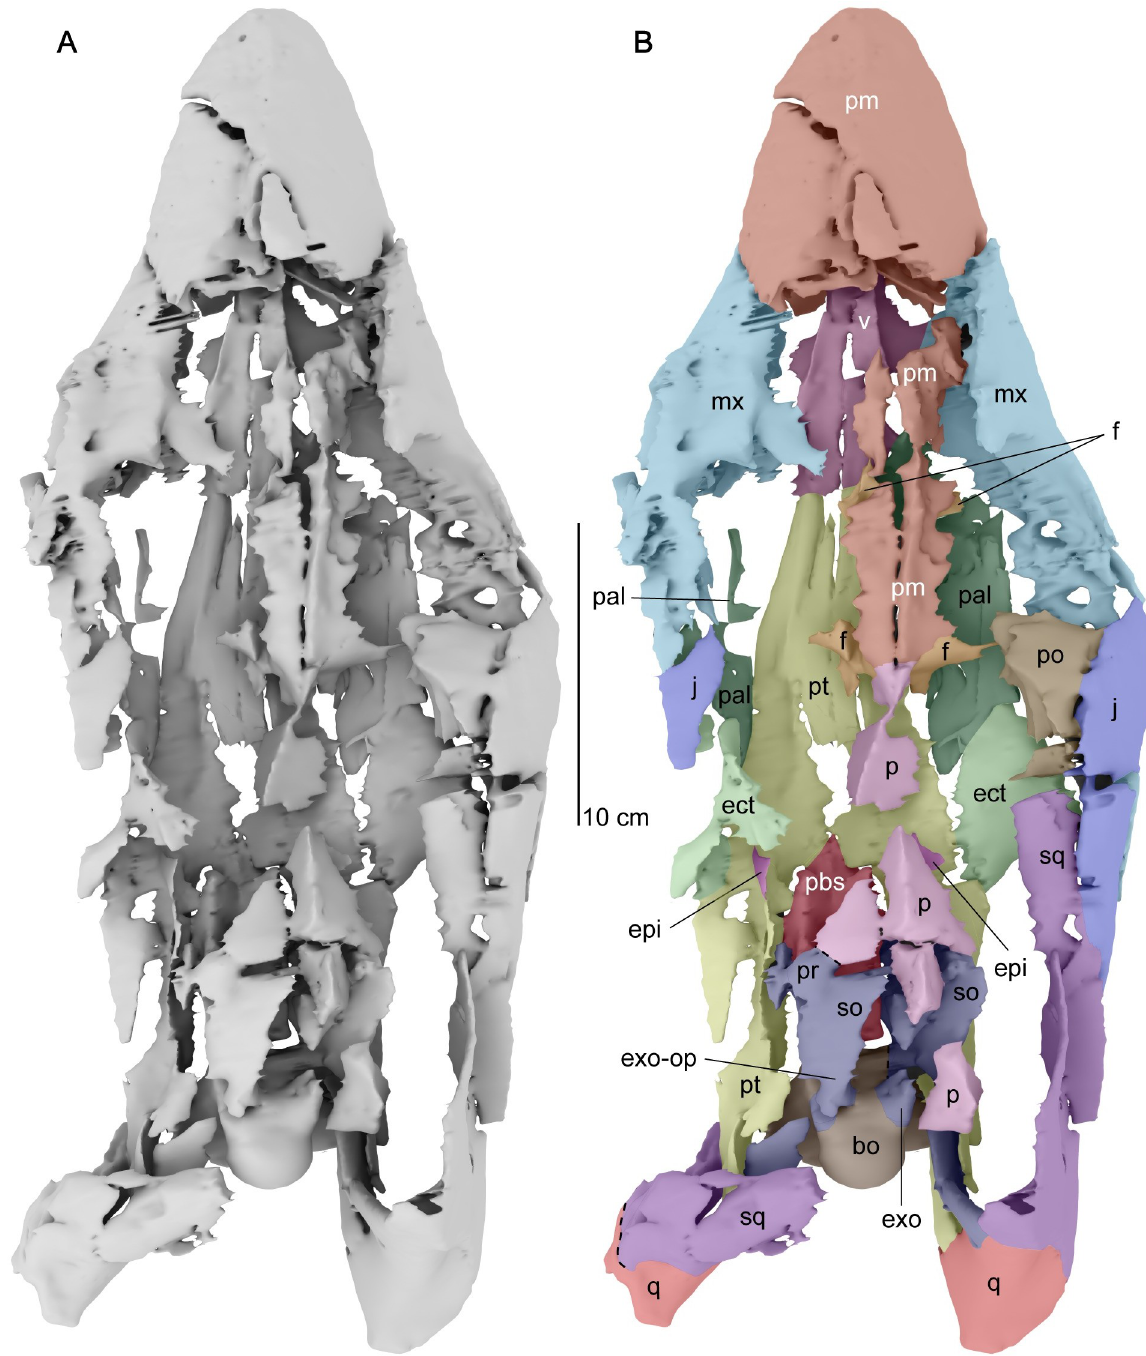
Fig 5. Three-dimensional digital model of the cranium of Cardiocorax mukulu (MGUAN PA278) in dorsal view. A. uninterpreted surface model. B. separate cranial elements labeled. Dashed lines indicate approximate sutural contacts. https://doi.org/10.1371/journal.pone.0255773.g005 Each premaxilla of MGUAN PA278 has a lateral tooth count of five, as indicated by the number of premaxillary alveoli (Fig 6). The lateral tooth count in MGUAN PA278 is the same as Styxosaurus snowii [42], Libonectes morgani [61], Tuarangisaurus keyesi Wiffen and